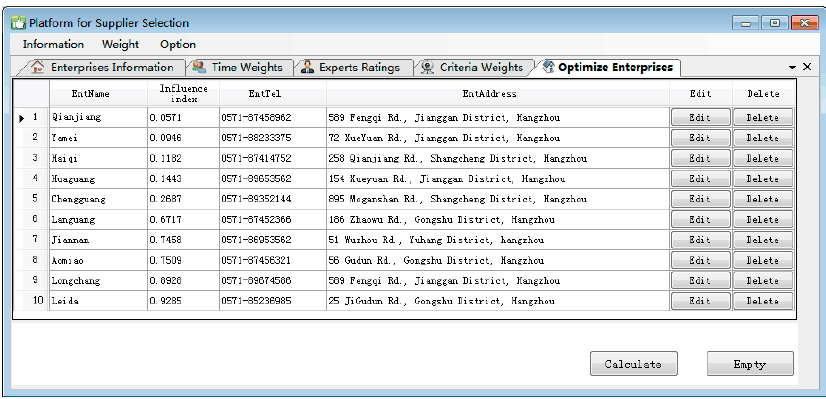
Figure 3. GUI of optimized enterprises.